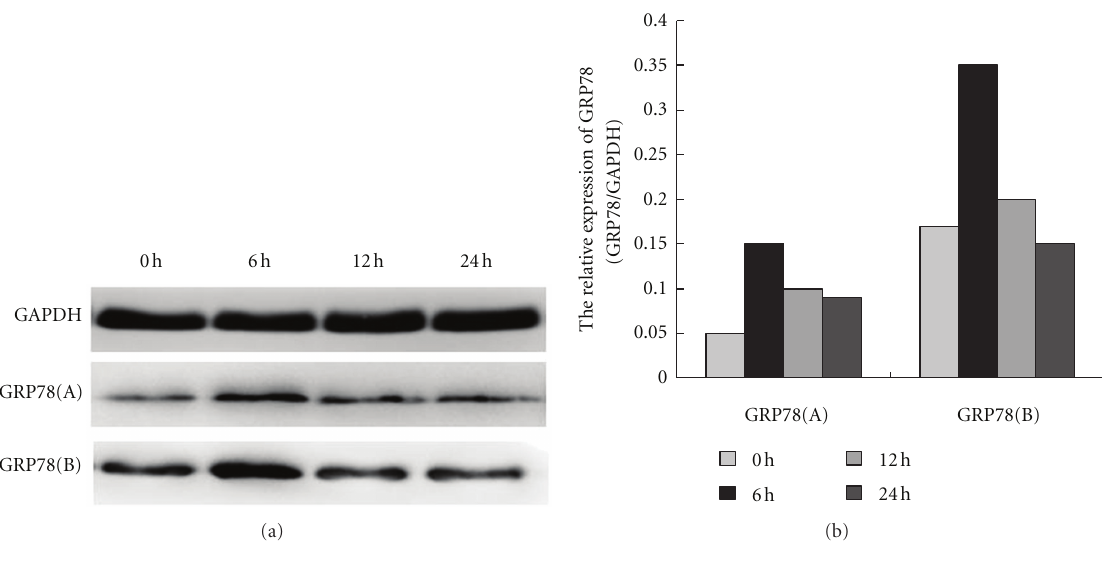
Figure 2: APC-induced GRP78 expression in the presence and absence of LPS stimulation. Following HUVEC treatment with 150 nM APC for 0, 6, 12, and 24h, upregulated GRP78 expression was initially detected at 6h by Western blot analysis (GRP78 (a), P < 0 . 05), and then generally decreased. After continuous exposure to 10ng/mL LPS for 24 h, HUVECs were treated with 150 nM APC for 0, 6, 12, and 24 h. Upregulated GRP78 expression was also detected at 6h by Western blot analysis (GRP78 (b), P < 0 . 05), and then generally decreased. A significant di ff erence in APC-induced GRP78 expression in the presence (b) and absence (a) of LPS stimulation was detected at 6 h, which indicated that 150 nM APC plays a more significant role in this e ff ect following LPS stimulation ( P < 0 . 05).